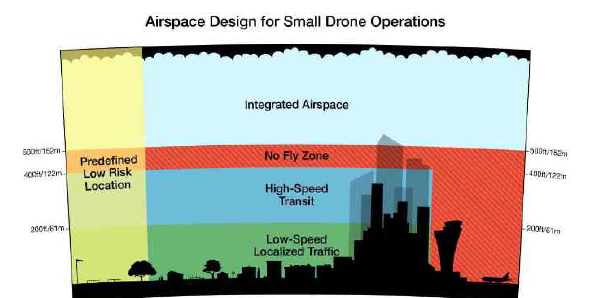
Figure 1. Amazon’s vertical airspace design for small UAV operations (source: Amazon)